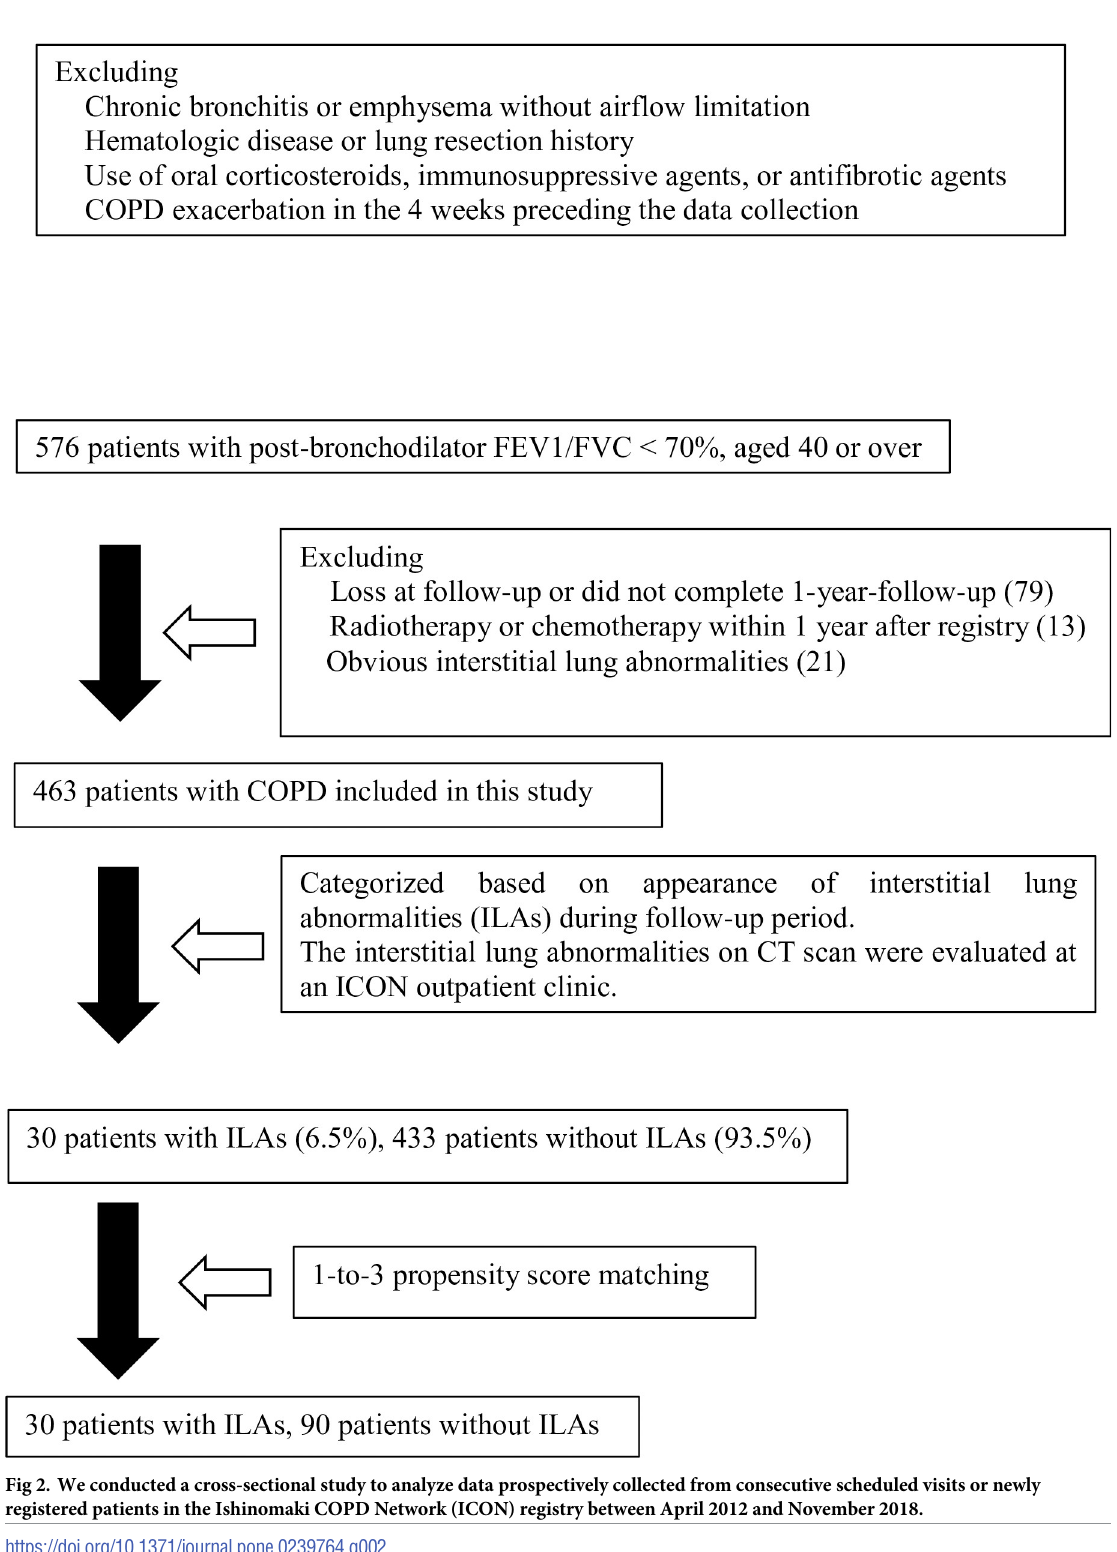
PLOS ONE | https://doi.org/10.1371/journal.pone.0239764 November10,